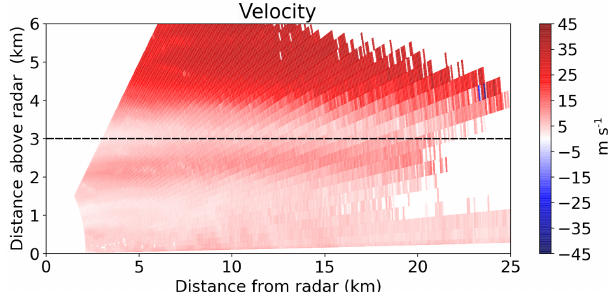
Figure 11. RHI of Doppler velocity at 11 ◦ azimuth at 06:25UTC from MXPol radar. The dashed black line shows the lower limit of the WCB (black contour in Fig. 5a, b, c). The Python ARM Radar Toolkit (Py-ART; Helmus and Collis, 2016) was used to plot the radar